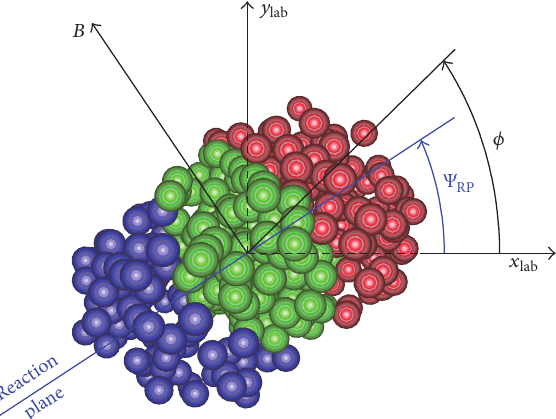
Figure 1: Schematic depiction of the transverse plane for a collision of two heavy ions (the left one emerging from and the right one going into the page). Particles are produced in the overlap region (green-colorednucleons).Theazimuthalanglesofthereactionplane and a produced particle are depicted here.